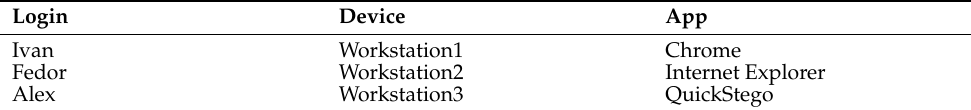
Table 7. Example of query results of the algorithm for Feature 2. Login Device App Ivan Workstation1 Chrome Fedor Workstation2